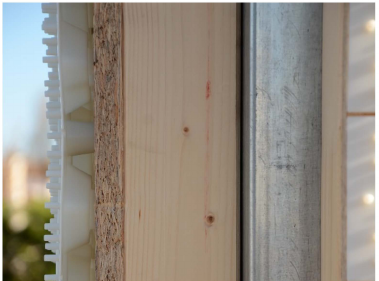
Figure 4. Wall section: (from left to right) skin, Oriented Strand Board (OSB) panel, timber stud, and steel column.